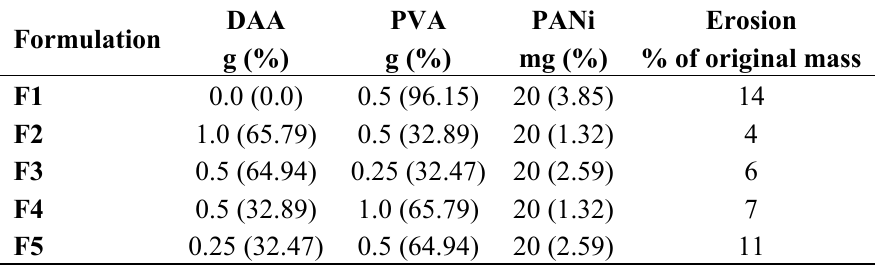
Table 3. Formulation template employed for preparing each ECH system.